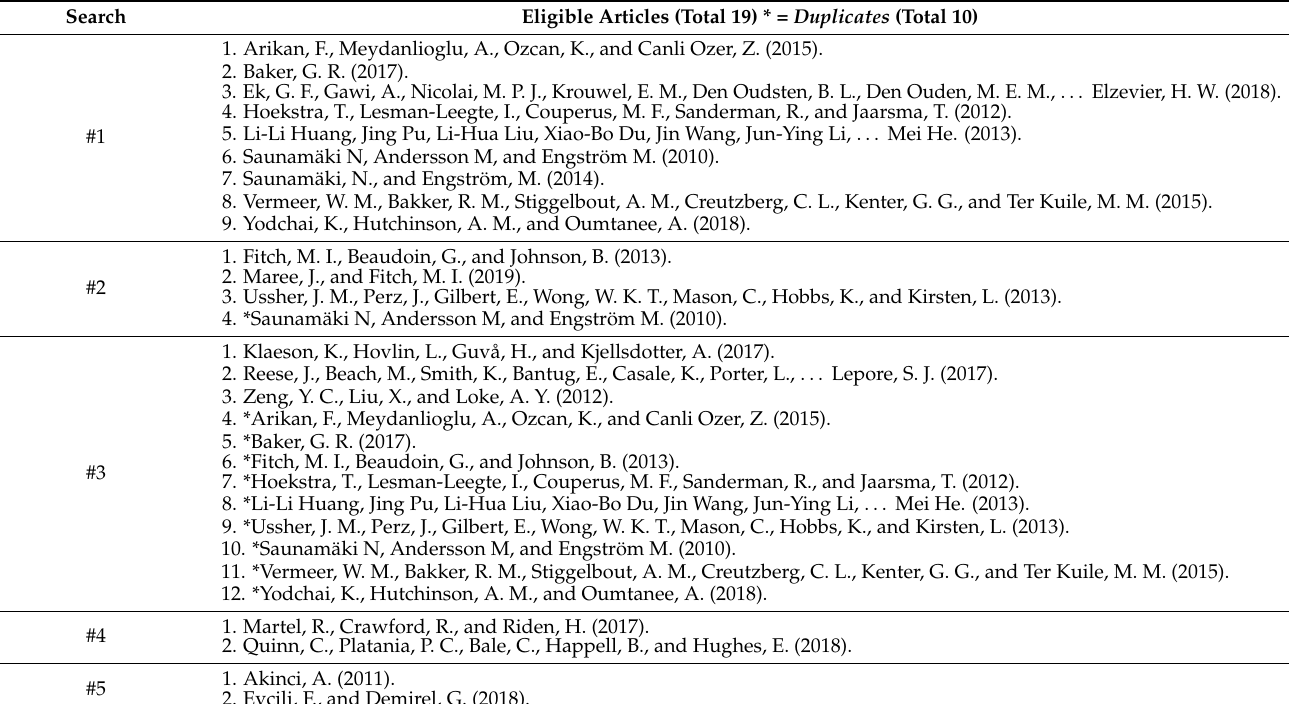
Table 2. Eligible articles from various database searches and search term combinations.